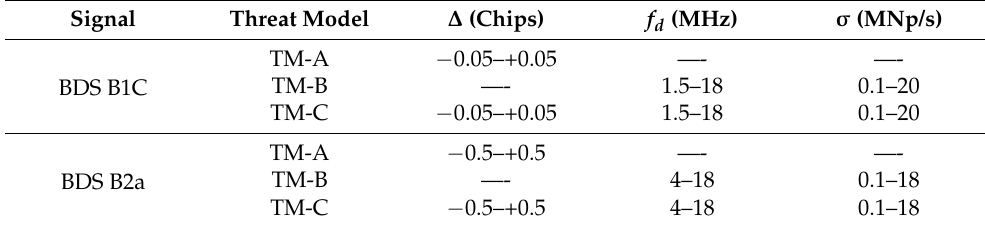
Table 2. The threat spaces of BDS B1C and B2a signals.